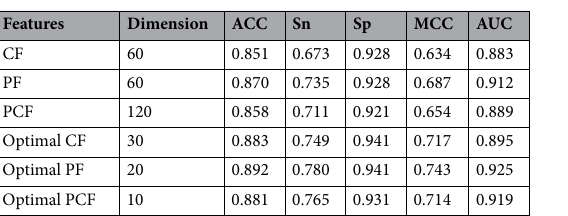
Figure 2. Performance evaluations of top 30 baseline models. ( A , B ) Cross-validation ACC and MCC as well as ( C , D ) Independent test ACC and MCC.